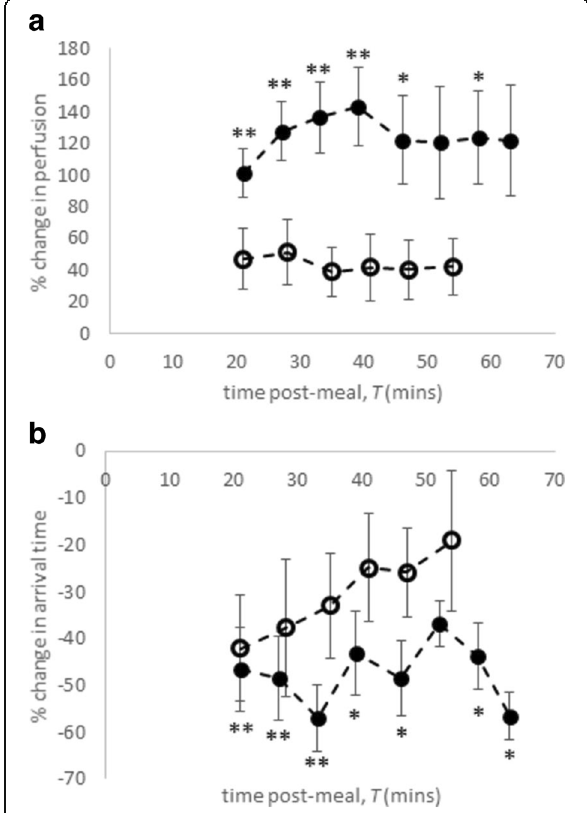
Fig. 5 Percentage change in liver tissue perfusion ( a ) and blood arrival time ( b ) to the liver following meal ingestion in healthy participants and patients with compensated cirrhosis (mean ± standard error of the mean). Filled circles indicate healthy participants and open circles indicate patients with compensated cirrhosis. Comparison of each time point with baseline, * p < 0.05, ** p < 0.01. T